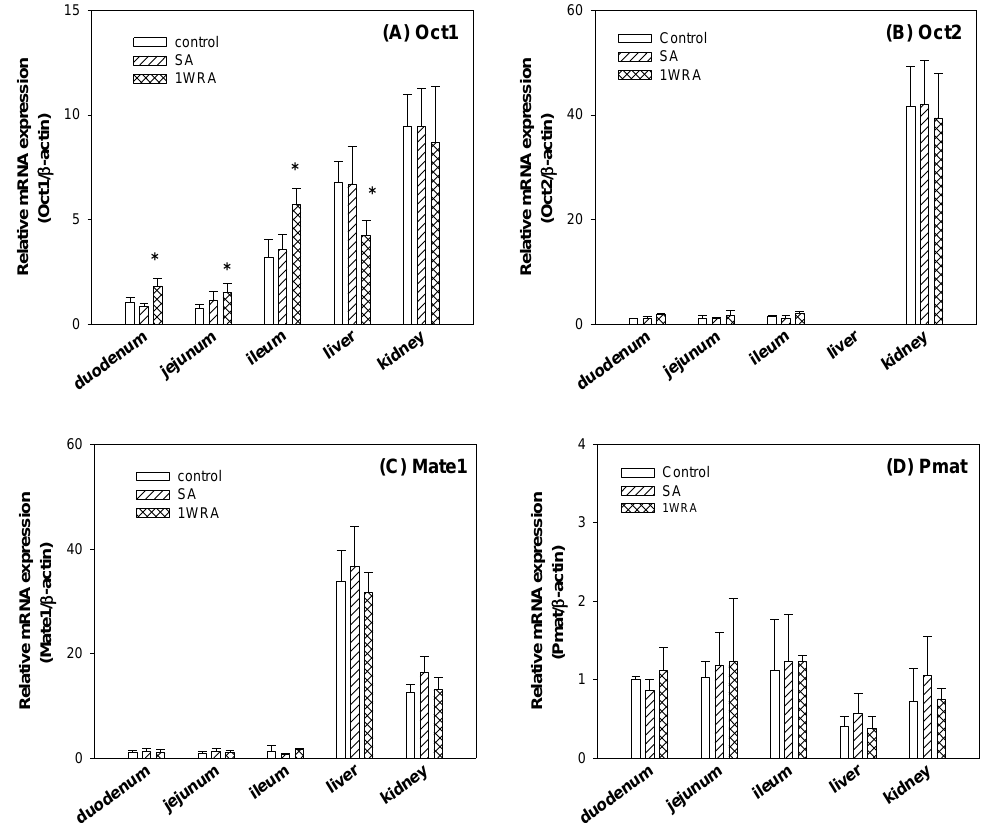
Figure 2. The mRNA expression of organic cation transporter 1 (Oct1) ( A ), Oct2 ( B ), multiple toxin and extrusion protein 1 (Mate1) ( C ), and plasma membrane monoamine transporter (Pmat) ( D ) in the duodenum, jejunum, ileum, liver, and kidney of rats in control, single RGE treatment (SA), and 1-week repeated RGE administration (1WRA) groups. Bars represent mean ± SD of three independent analyses; * p < 0.05 compared with control group (by Student’s t-test).